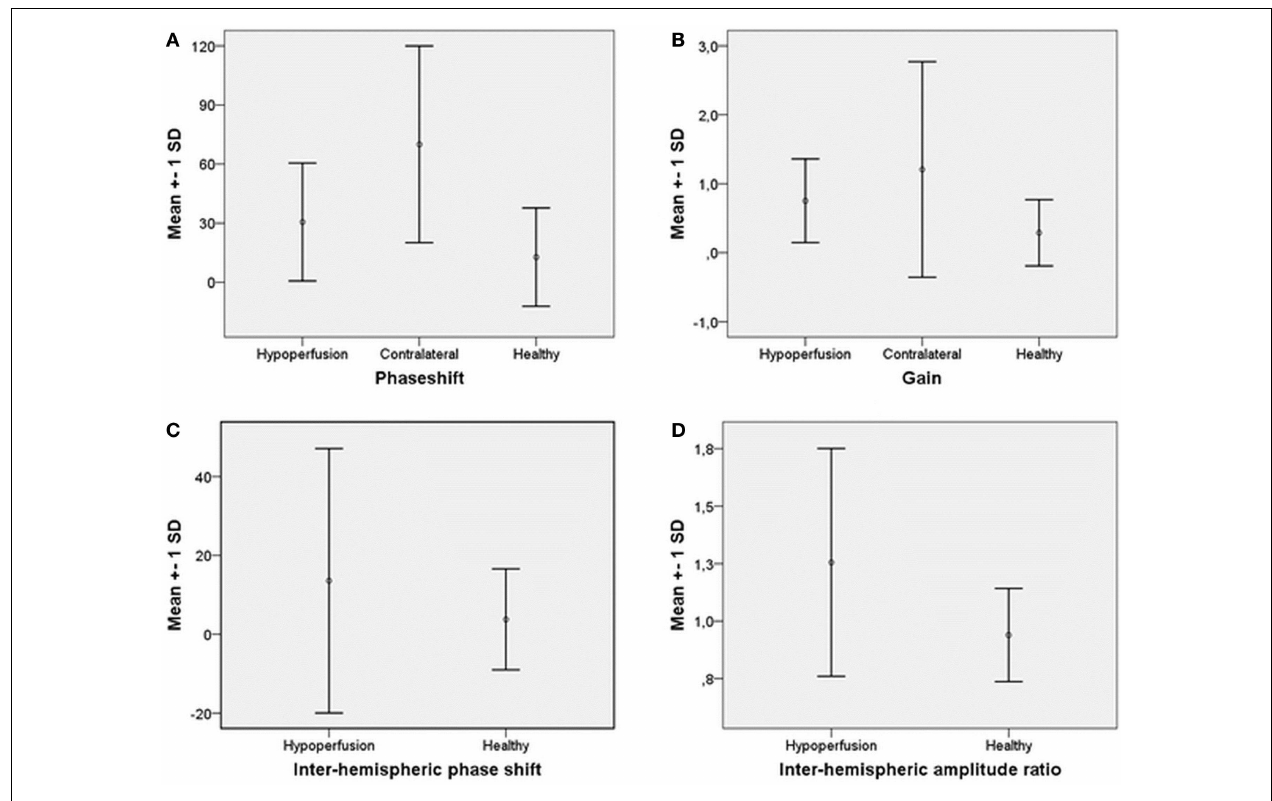
phase shift hypoperfusion to contralateral side and for healthy. (D) Inter-hemispheric amplitude ratio contralateral/hypoperfusion side and for healthy.